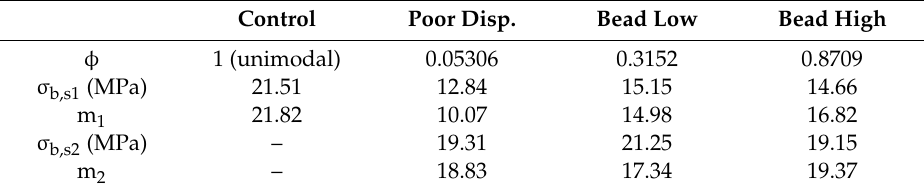
Table 3. Weibull Fitting Parameters for σ b Distributions.